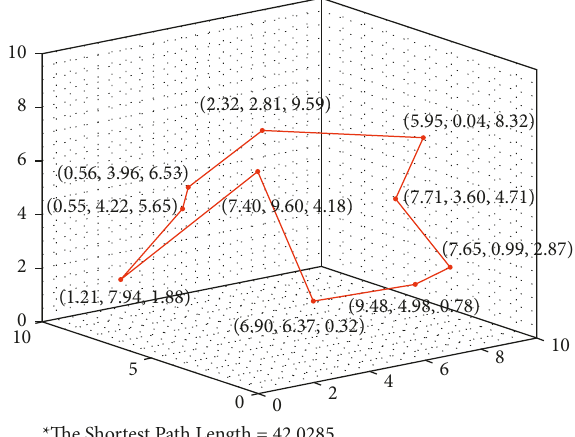
Figure 2: The 3D figure of initial points and the shortest path of 3D-TSP for the